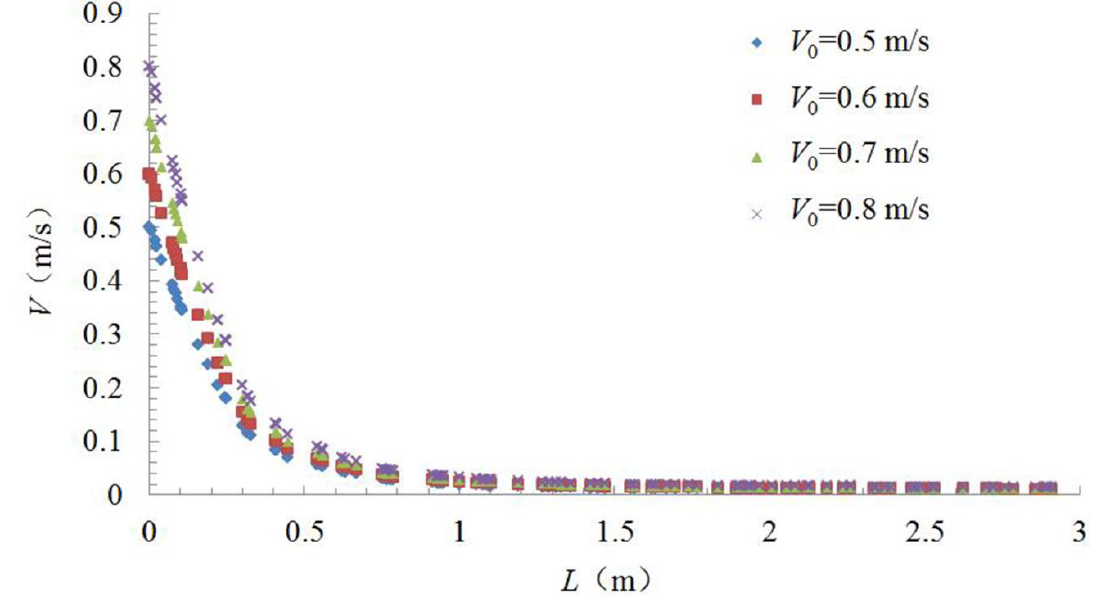
Figure 3. Change in hood axis velocity ( V ) with distance from hood face ( L ) for various hood face velocities ( V 0 ).